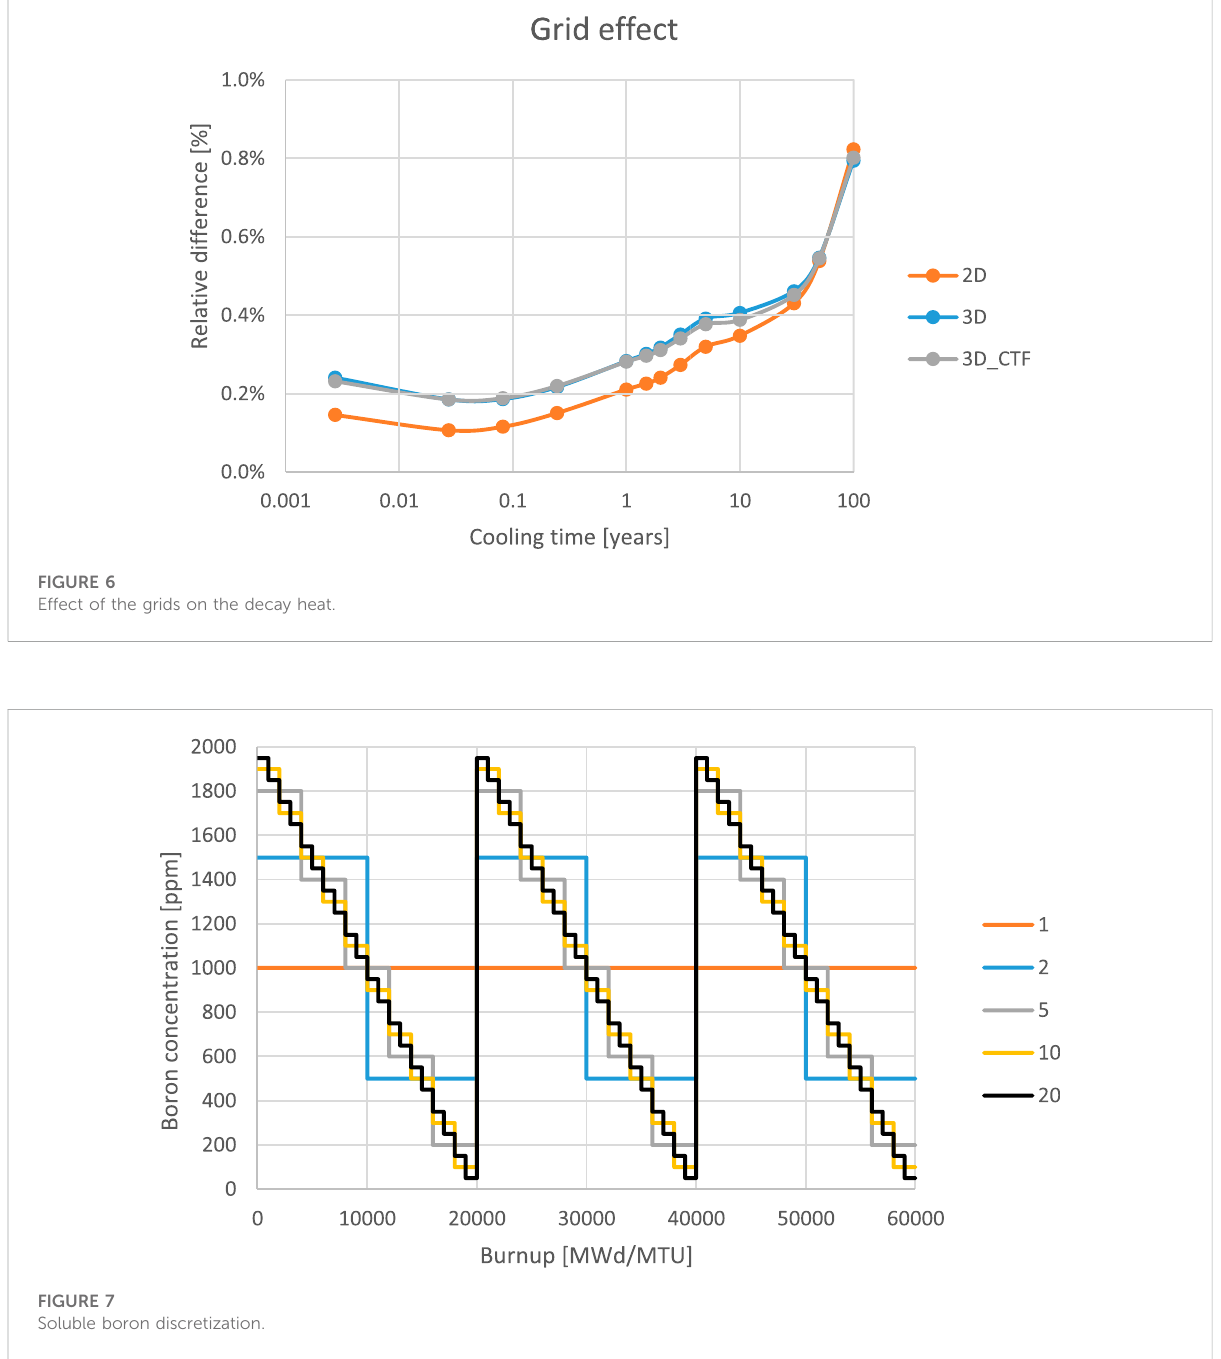
library in ACE format based on the ENDF/ B-VII.1 evaluated nuclear data fi les (Chadwick et al., 2011) were used with 1,424 nuclides taken into account in the depletion/decay calculation. For each statepoint 30,000 neutrons in 900 active neutron cycles were tracked. The statistical uncertainty for the multiplication factor